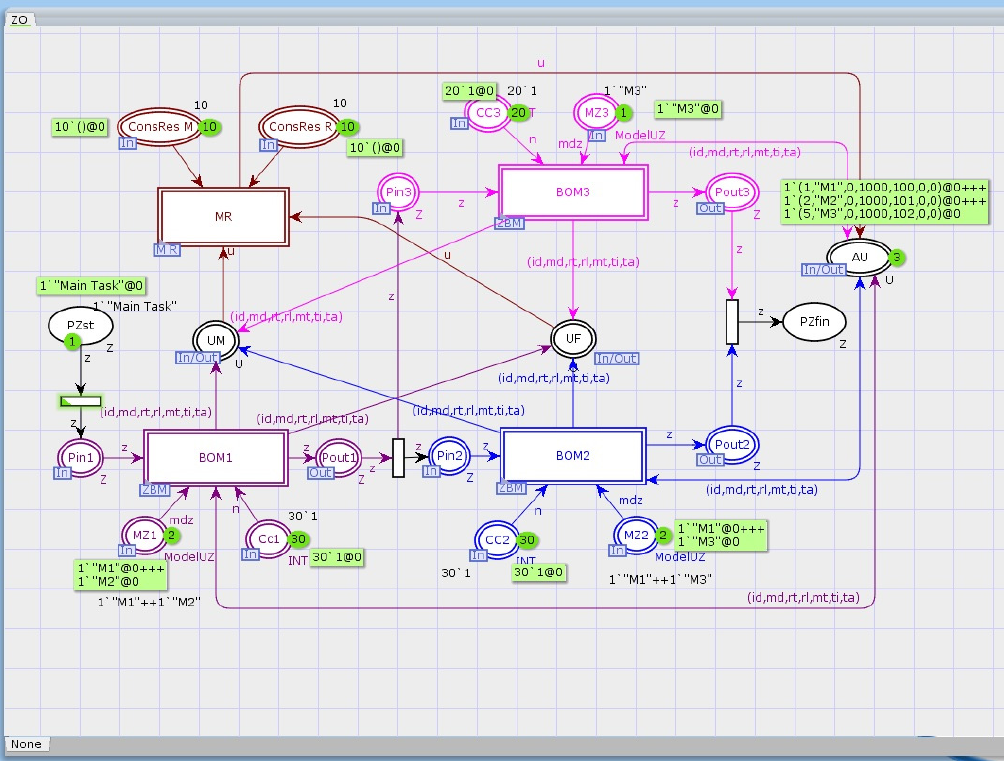
Figure A3. HPN AV initial marking.